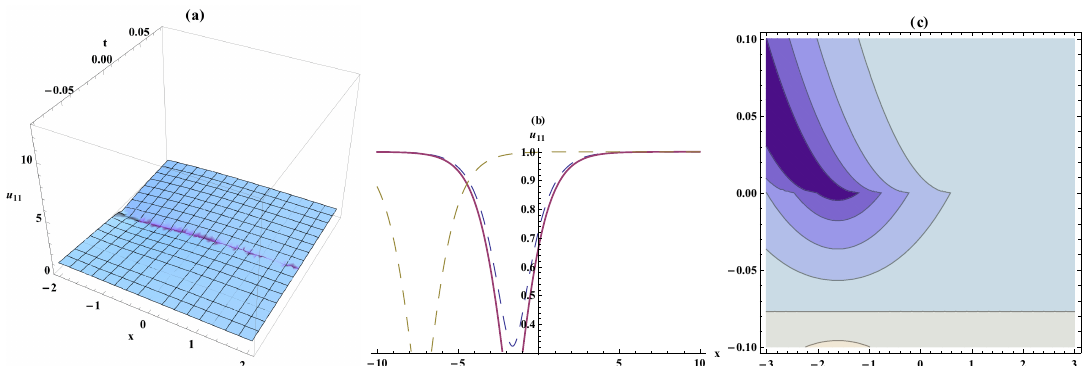
Figure 8. Solitary wave, the bistable wave amplitude and contour plots for Equation (63). On the respectively interval { x , − 2.05,2.05 } , { t , − 0.08,0.08 } , { x , − 10,10 } , { t , − 1,1 } , { x , − 3,3 } , { t , − 0.1,0.1 } .